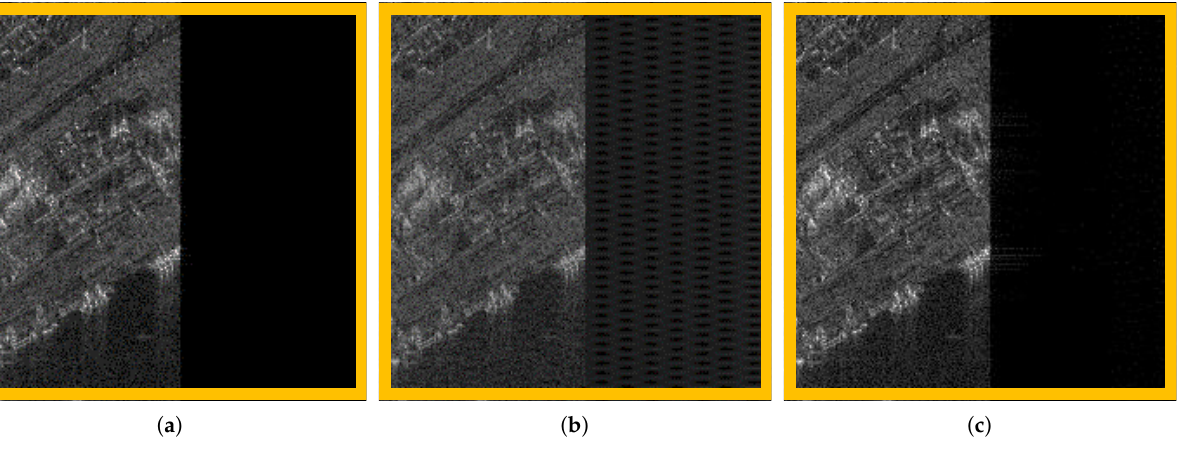
Figure 18. The local imaging area in Figure 17. ( a ) The reference image. ( b ) Without removal of synchronization signal. ( c ) After removal of synchronization